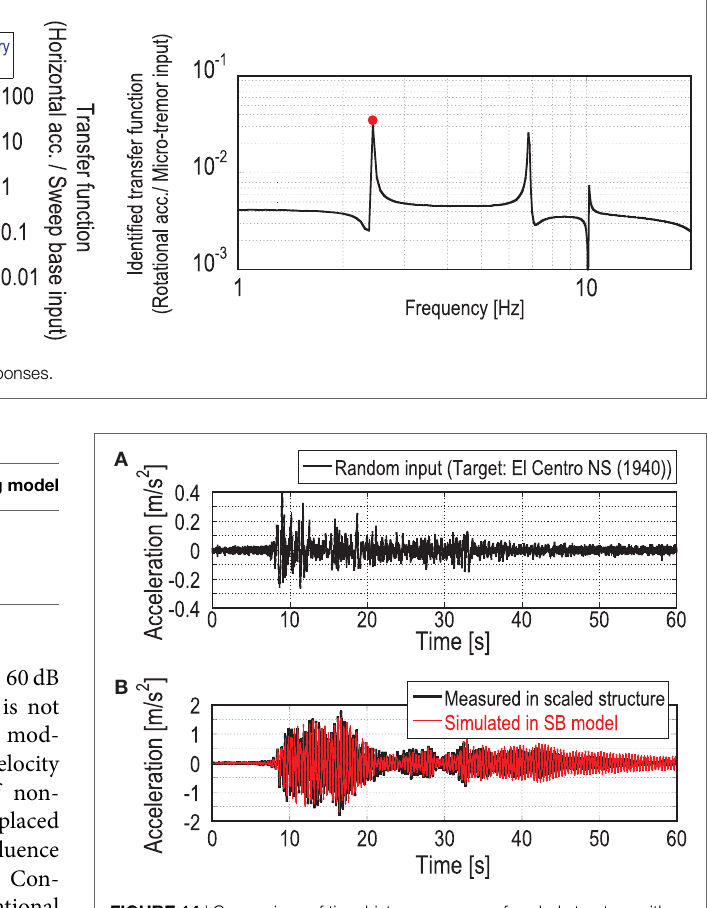
FIGURE 14 | Comparison of time history response of scaled structure with identified shear-bending model (SB model). (A) Base input on shaking table (B) top-floor horizontal acceleration.